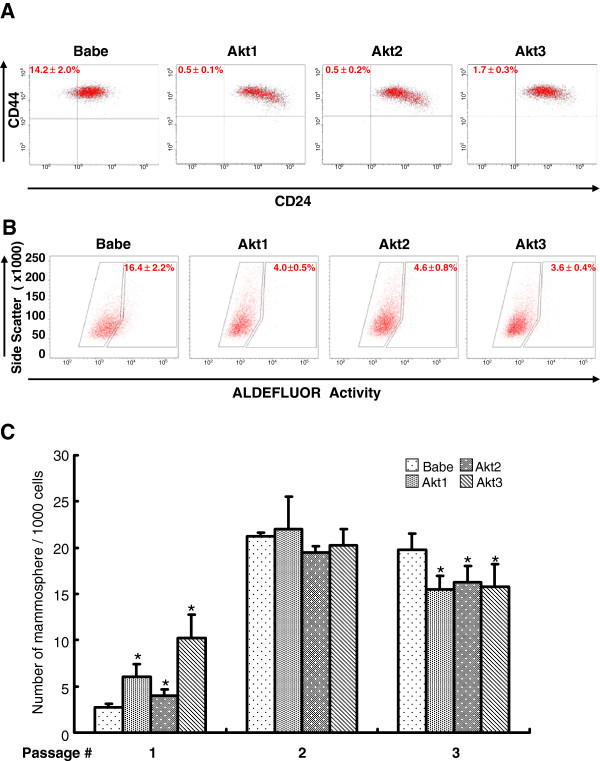
Activated Akt signaling decreases breast stem/progenitor cell subpopulations. MCF10A cells were infected with retroviruses to respectively express empty vector (Babe), Akt1, Akt2, or Akt3 and then subject to PE-CD24 and FITC-CD44 double-staining (A), ALDEFLUOR assay (B), or serially passaged mammosphere formation assay from which mammospheres were counted under a microscope by independent investigators (C). * Denotes that the number of mammospheres obtained from Akt-expressing cells differed significantly (p < 0.05) from the vector controls.